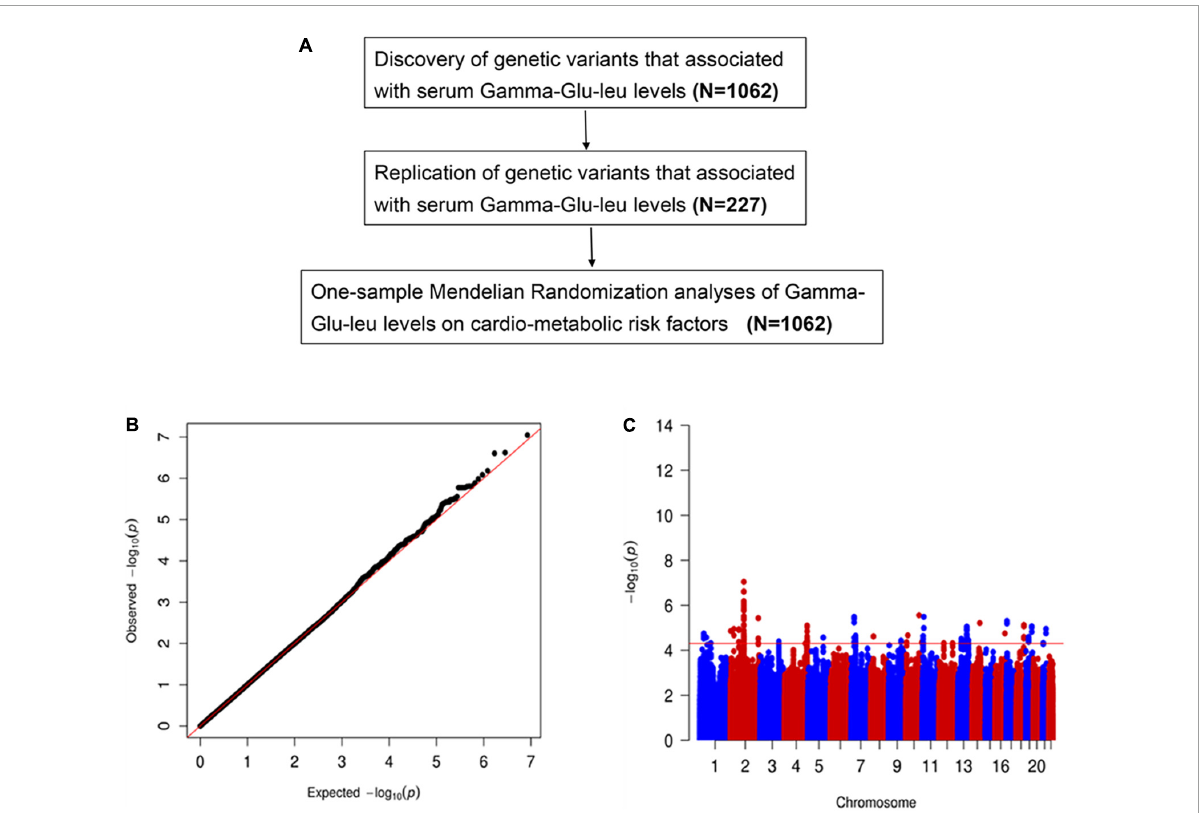
FIGURE1 (A) The study overview. The cardio-metabolic risk factors include body mass index, waist circumference, waist circumference to hip circumference ratio, total triglyceride, total cholesterol, low-density lipoprotein cholesterol, low-density lipoprotein cholesterol, systolic blood pressure, diastolic blood pressure, fasting plasma glucose, insulin resistance index, and insulin and uric acid. (B) The quantile-quantile plot for genomic associations of Gamma-glutamyl-leucine (Gamma-Glu-Leu) ( N = 1,062). (C) The Manhattan plot for genomic associations of Gamma-Glu-Leu ( N =